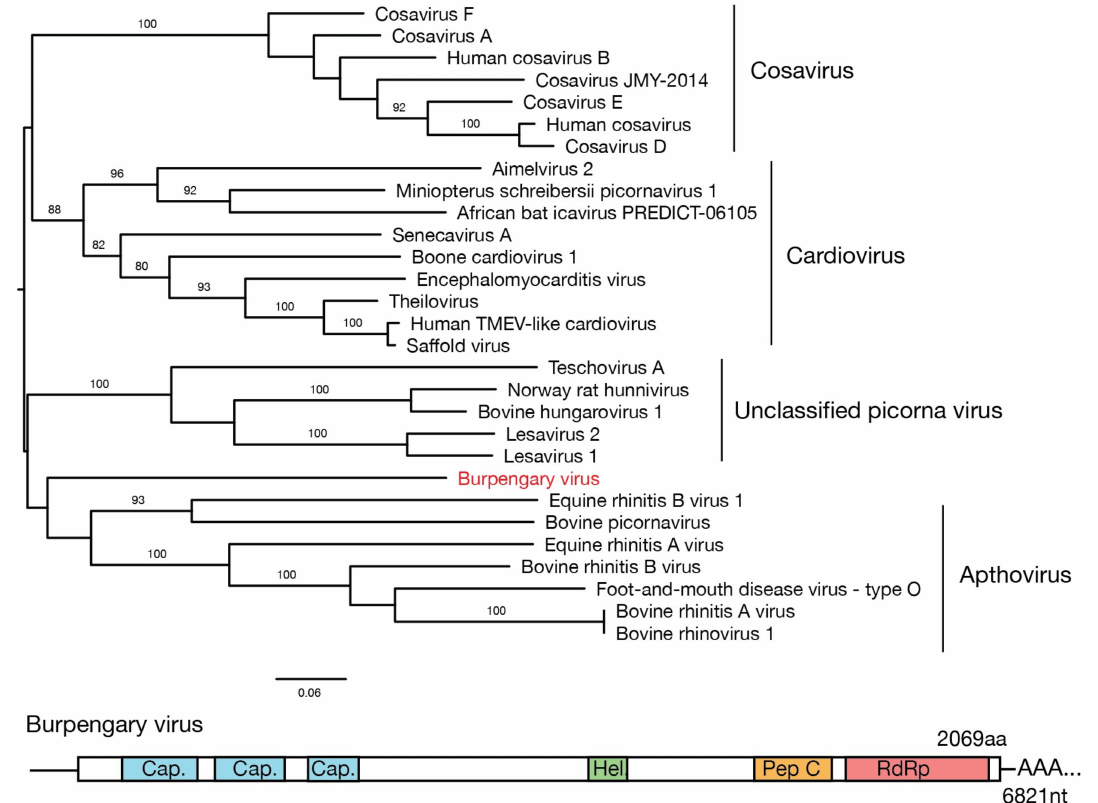
Figure 1. Maximum likelihood phylogenetic tree showing the position of the newly identified Burpengary virus (in red) in relation to other members of the Picornaviridae . The tree is midpoint rooted for clarity, and bootstrap support values of over 70% are shown. Genera within the Picornaviridae are indicated to the right of the tree. The predicted genome structure of the novel virus is shown below the phylogeny, with the single coding-complete ORF and conserved regions indicated as: